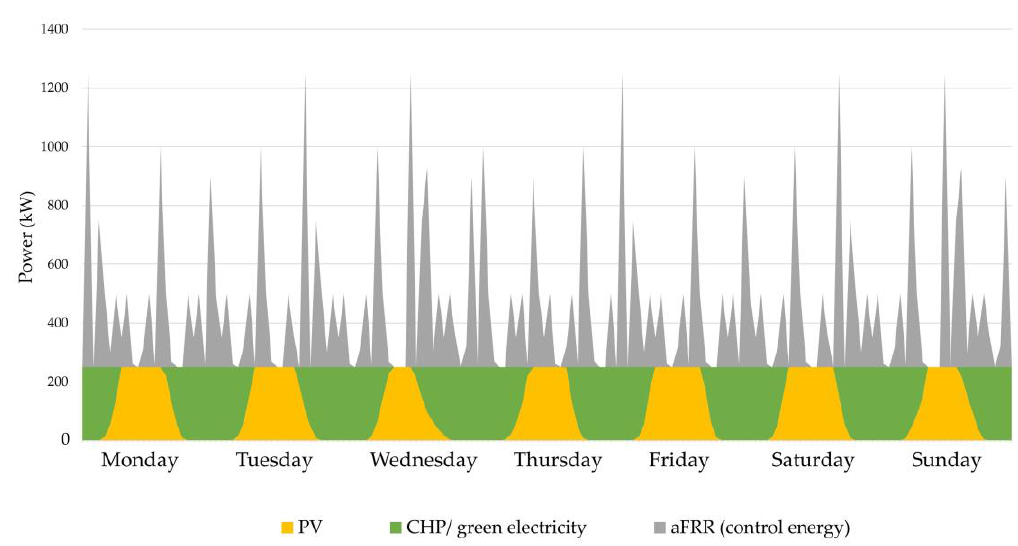
Figure 6. Example of electricity consumption for the electrolyzer in a summer week [41].